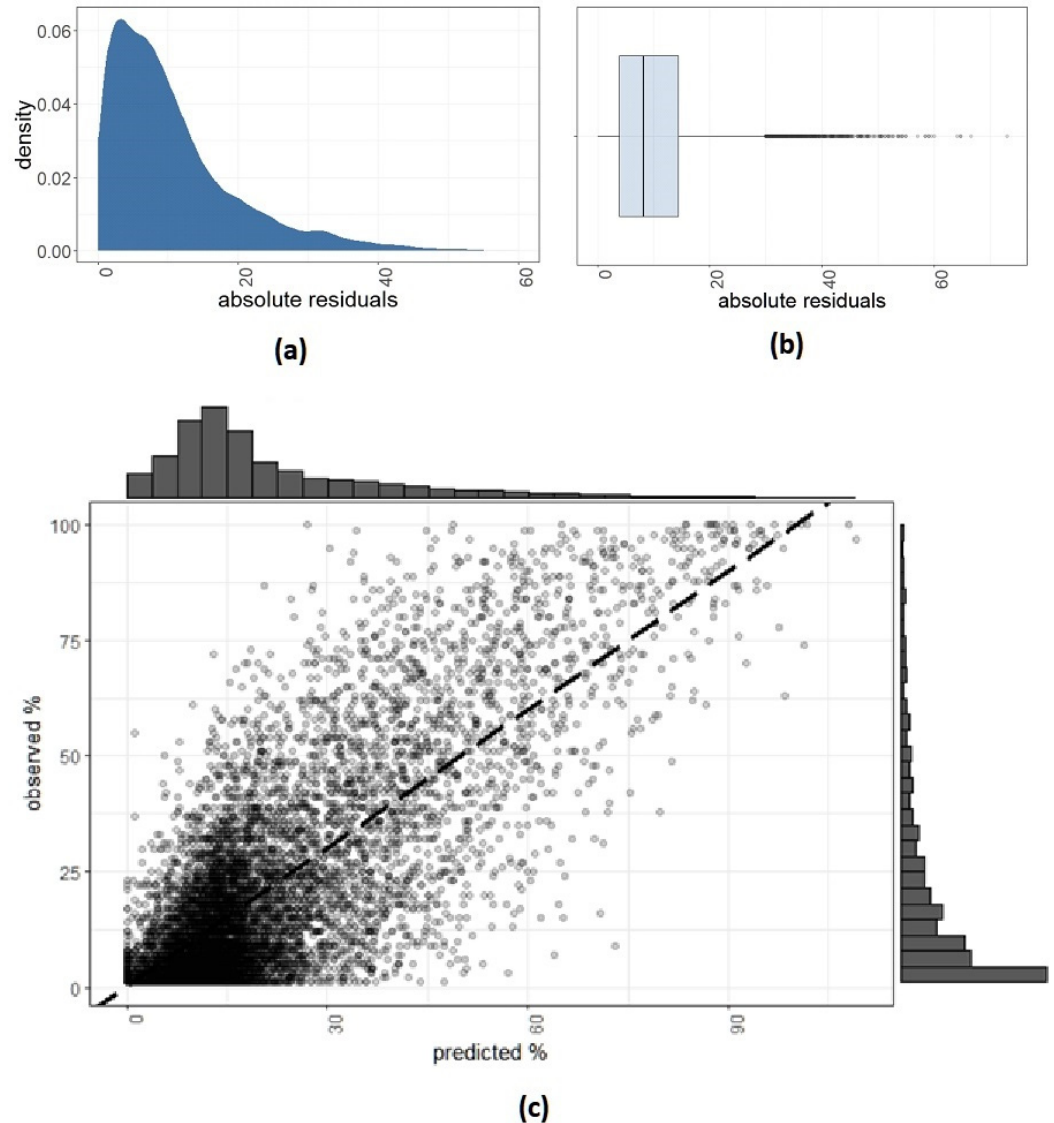
Figure 7. Assessment of the final model residuals. ( a ) Density plot of absolute residuals of the ENET model; ( b ) boxplot of absolute residuals (median value = 8.2%); ( c ) scatterplot of the predicted vs. observed values with distribution histograms.